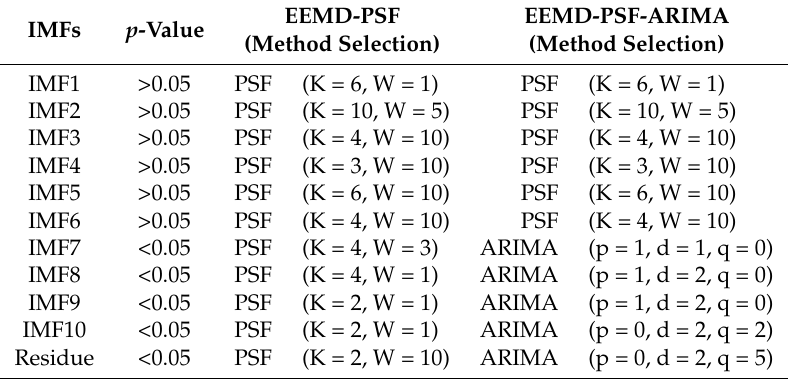
Table 8. Prediction method selection for IMFs in EEMD-PSF and EEMD-PSF-ARIMA models for wind speed